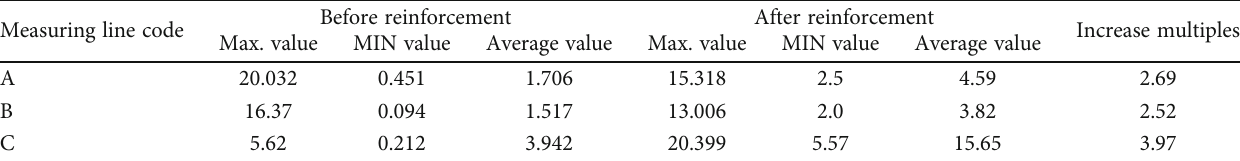
Increase multiples